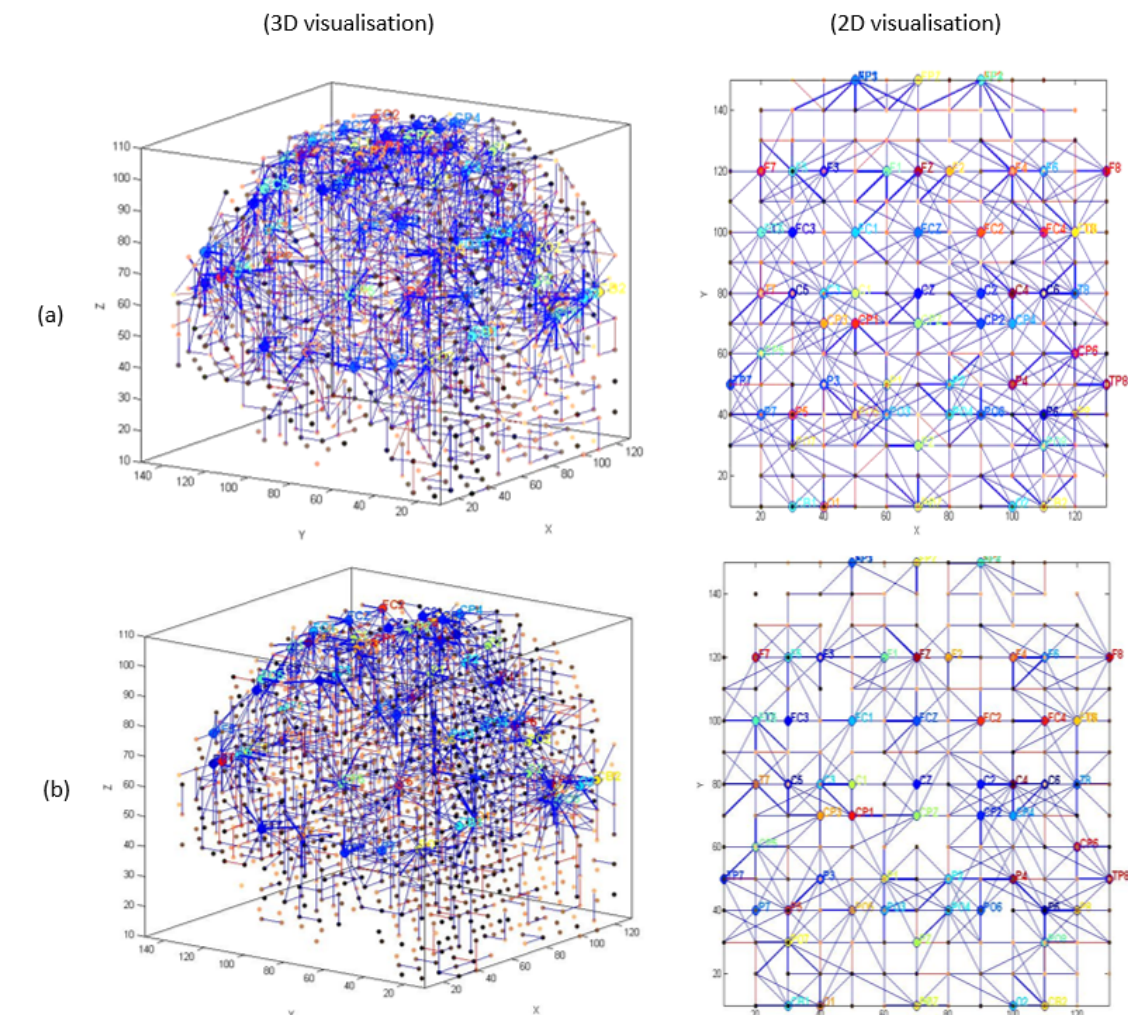
Figure 7. The neuronal connections created for the experimental group in the brain-inspired SNN models reflect the functional connectivity in response to distractor stimuli ( a ) before (T1) and ( b ) after the mindfulness training (T2).